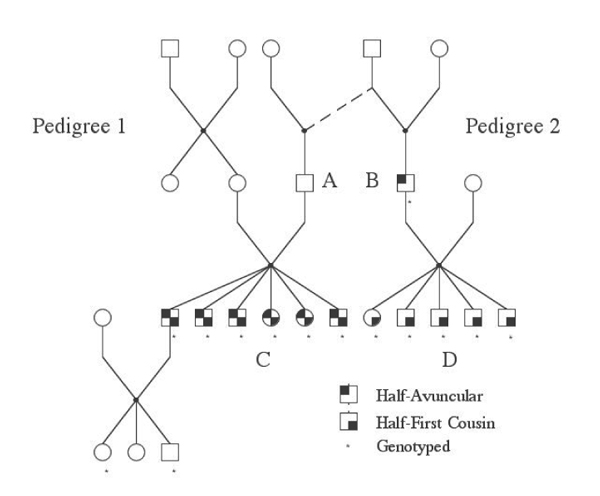
Pedigree error example 2 Pedigrees 1 and 2 were unrelated in the data. B was found to be a half-uncle to the siblings in C, and they in turn to be half-first-cousins to the siblings in D, supporting the joining of the two pedigrees as indicated with the dashed line.